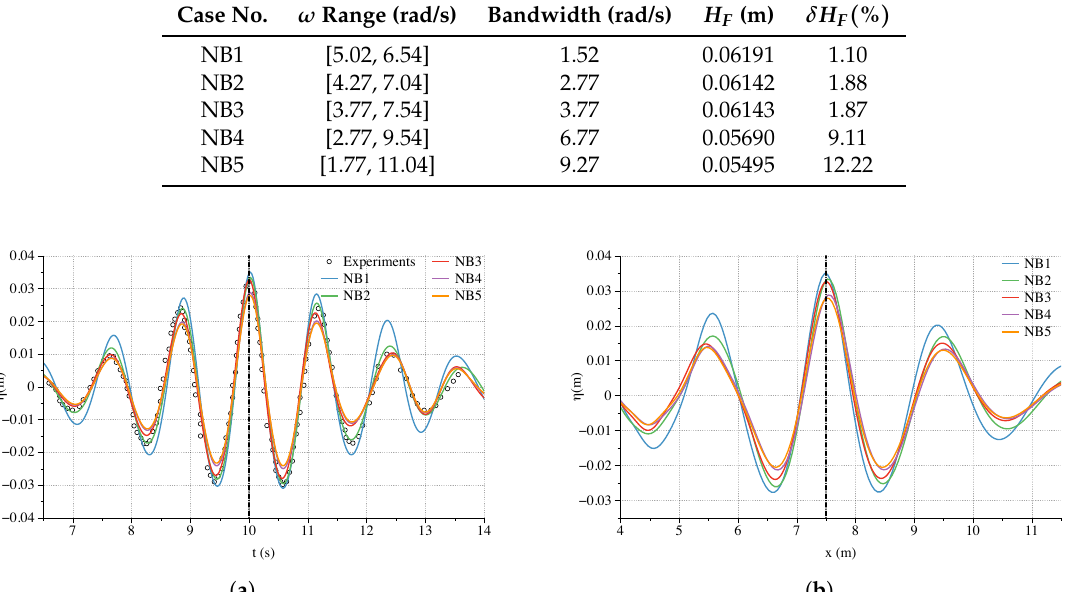
Table 4. The input wave properties with different bandwidth for the wave spectrum. Case No.